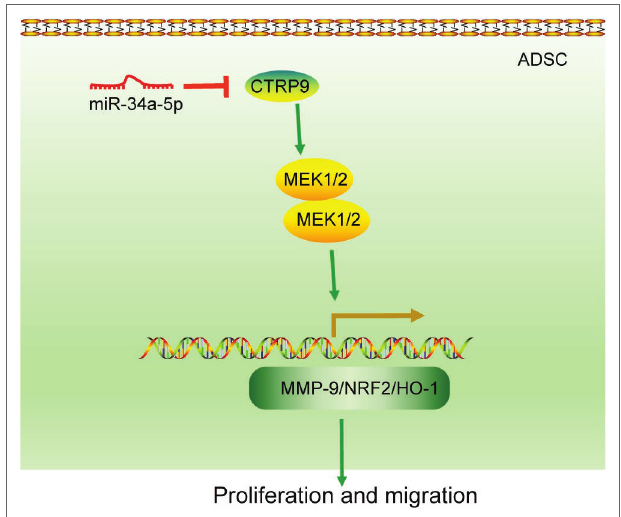
FIGURE 7 | A schematic representation of the role of miR-34a-5p in the function of ADSCs in the mouse MI model. miR-34a-5p targets and negatively regulates the expression of CTRP9. Up-regulated CTRP9 could enhance the proliferation and migration of ADSCs by increasing the expression of ERK1, MMP-9, NRF2, MnSOD and HO-1. Therefore, down-regulation of miR-34a-5p plays a promoting role in the protective effect of ADSCs against MI damage by up-regulating CTRP9. miR-34a-5p, microRNA-34a-5p; ADSCs, adipose-derived stem cells; MI, myocardial infarction; CTRP9, C1q/tumor necrosis factor-related protein-9; MMP-9, matrix metalloproteinase-9; NRF2, nuclear factor (erythroid-derived 2)-like 2; HO-1, heme